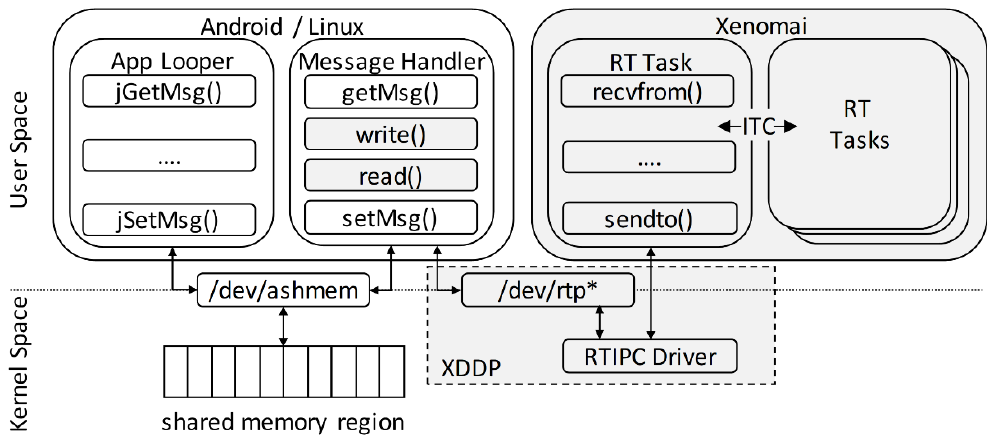
Figure 2. Thread model of integrating Android applications with real-time Xenomai tasks.